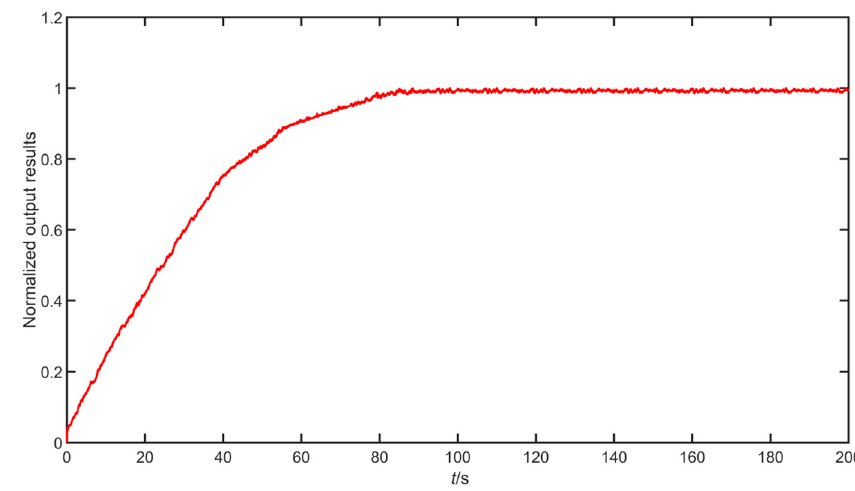
Figure 8. Open-loop step normalization results of pneumatic control valve.